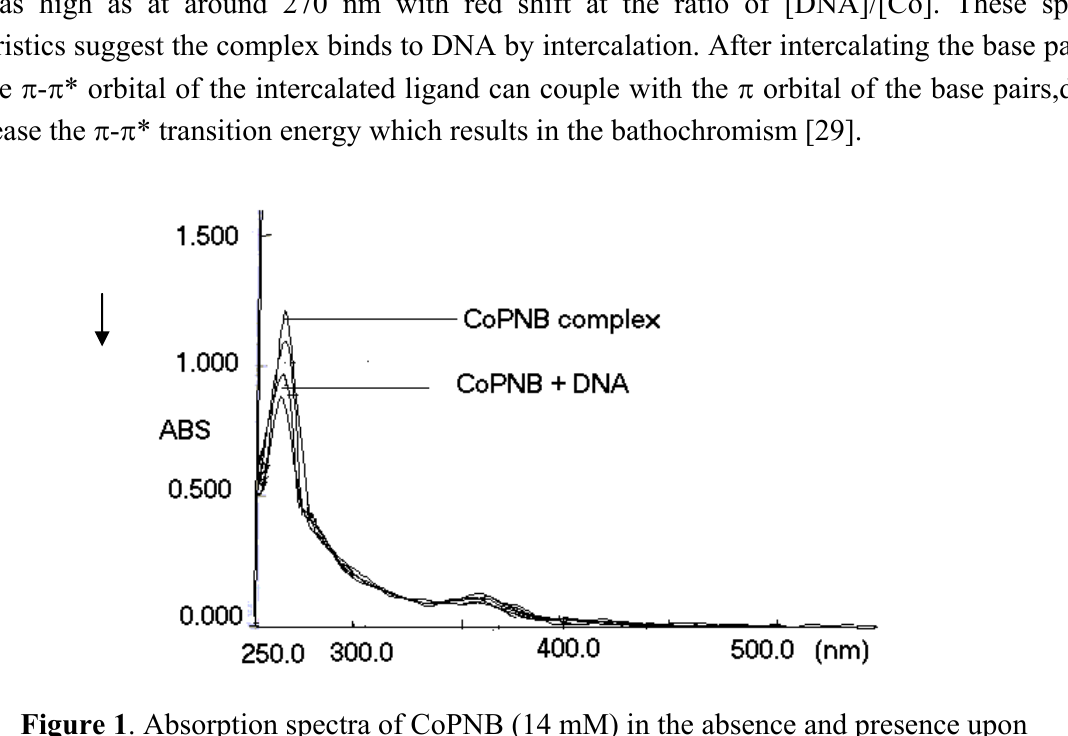
Figure 1 . Absorption spectra of CoPNB (14 mM) in the absence and presence upon addition of genomic DNA (0-10 mM). Arrow represents the absorbance changing when concentration of genomic DNA is increased.